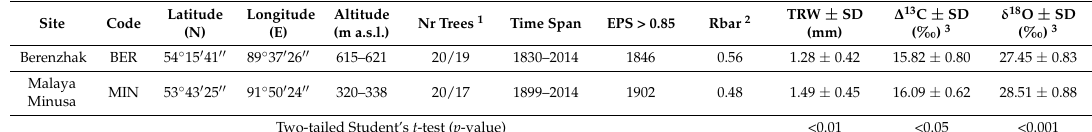
Table 1. Geographic and dendrochronological characteristics of the sampling sites. Abbreviations: EPS, Expressed Population Signal; Rbar, mean inter-series correlation; TRW, tree-ring width; ∆ 13 C, carbon isotope discrimination; δ 18 O, oxygen isotope composition. The mean values of tree-ring traits are estimated over the period 1940–2014 and the variability is expressed as standard deviation ( ± SD). The statistical significance of the differences in tree-ring mean values is also provided according to two-tailed Student’s t